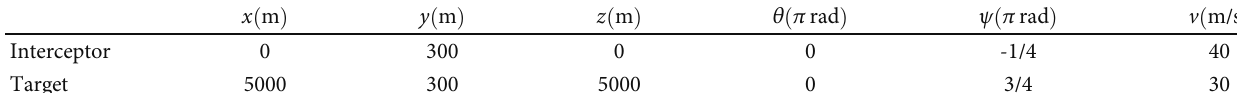
Table 3: The initial states of the interceptor and the target in example